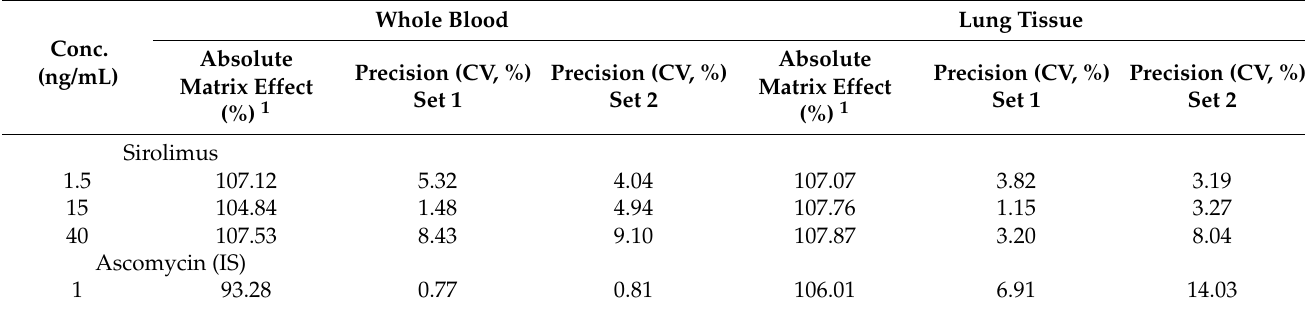
Table 4. Matrix effect for sirolimus and IS in porcine whole blood and lung tissue samples.